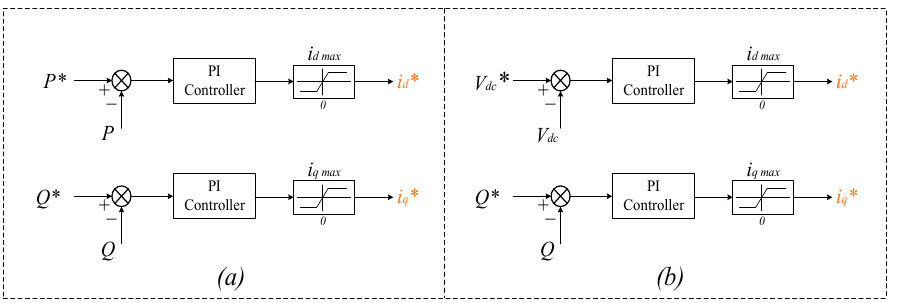
Figure 13. The dq-frame outer control loop of a grid-connected power converter, ( a ) P-Q control mode, ( b ) V dc -Q control mode.